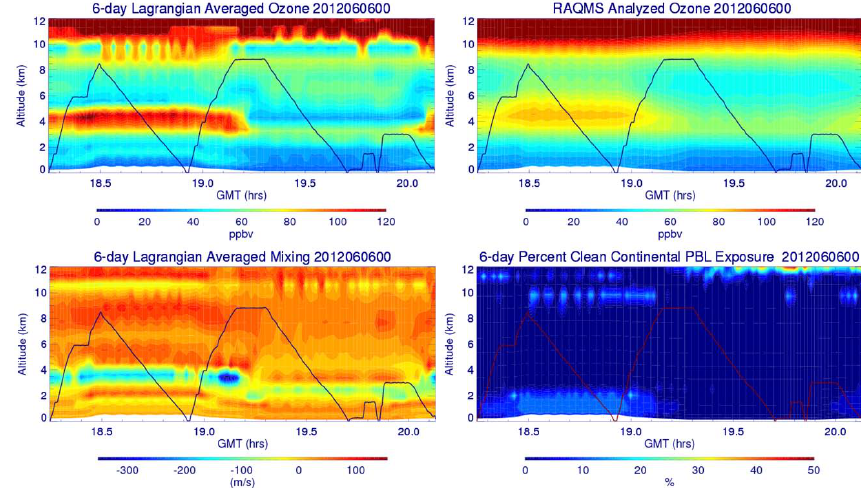
Fig. 9. RAQMS RDF O 3 (ppbv, upper left), analyzed O 3 (ppbv, upper right), RDF mixing efficiency (ms − 1 , lower left), and % clean continental PBL exposure (%, lower right) for AJAX flight on 5 June 2012.